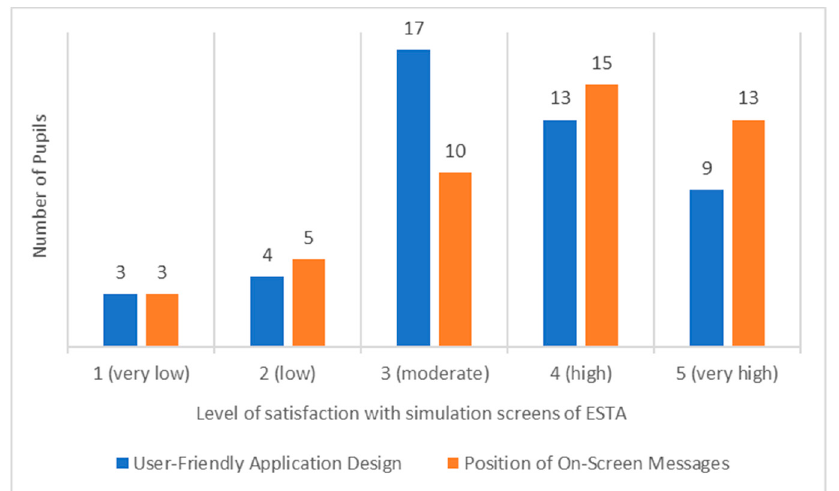
Figure 5. ESTA’s simulation screens overall satisfaction rating scale concerning the user interface design and the position of on-screen messages.